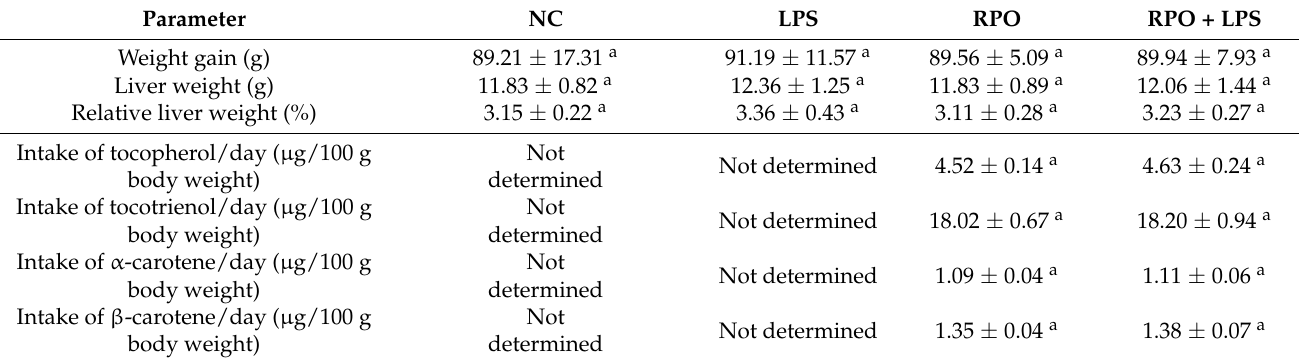
Table 3. Effect of RPO supplementation on weight parameters, daily vitamin E and carotene intakes in LPS-induced